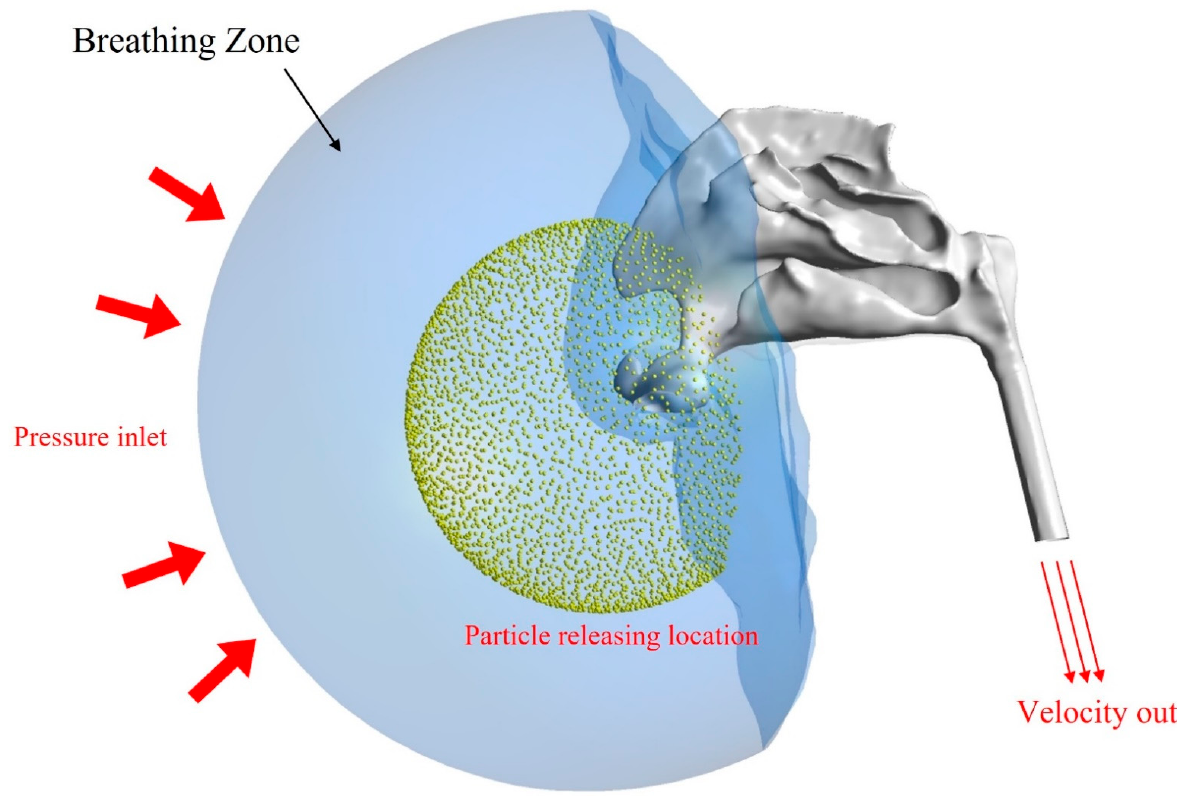
Figure 1. Model setup of the realistic human nasal airway, where the yellow point cloud illustrates the spherical particle releasing location with a radius of 3 cm in front of the nostrils. Fluent Meshing (ANSYS Fluent) was used to generate computational mesh (Figure 2). To supply computational efficient mesh, polyhedral elements with typical cell dimen- sion of 0.5 mm were employed in this study. A total of 8 layers of prism layers were at- tached along the nasal wall to simulate near wall region. The final mesh elements after mesh independence test were 1.3 million.